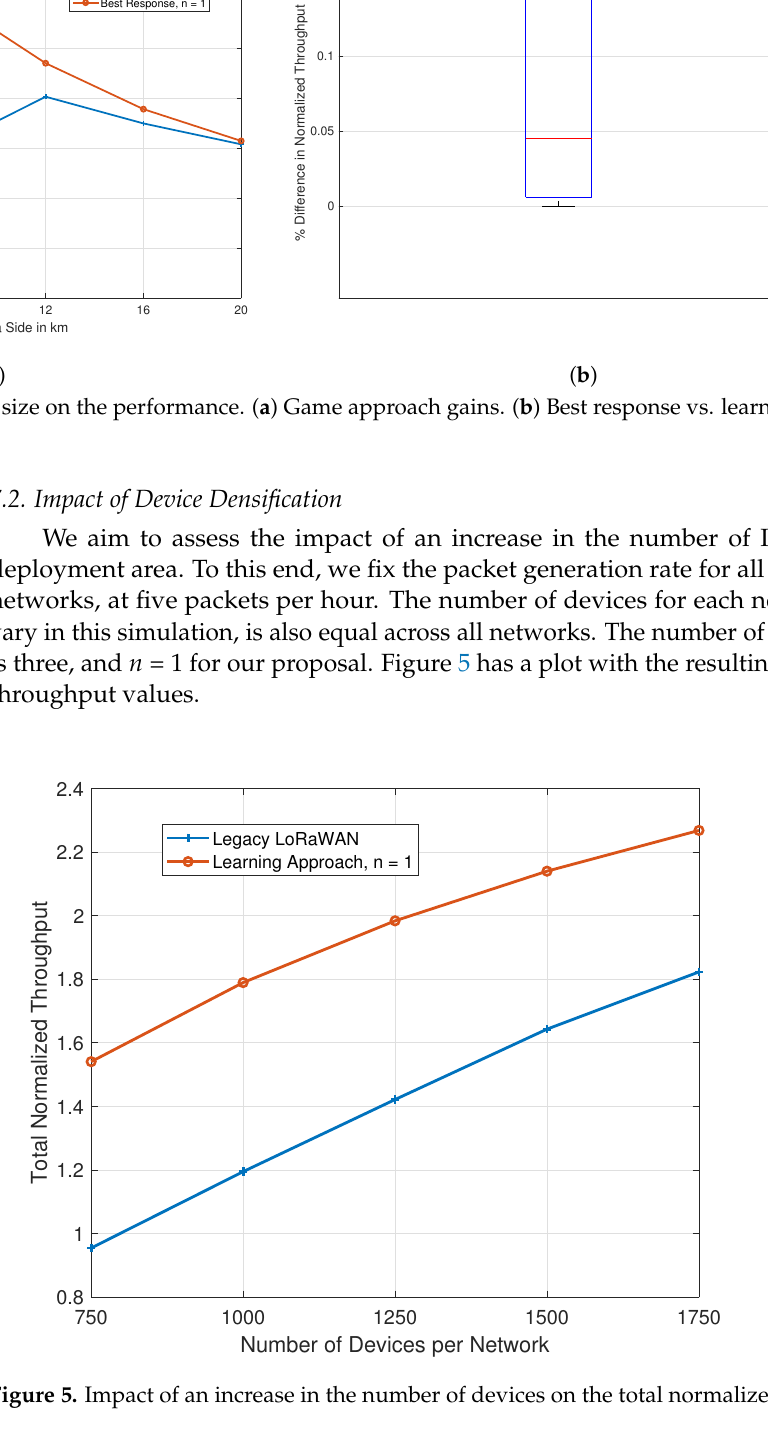
as compared to 1.82 for the legacy